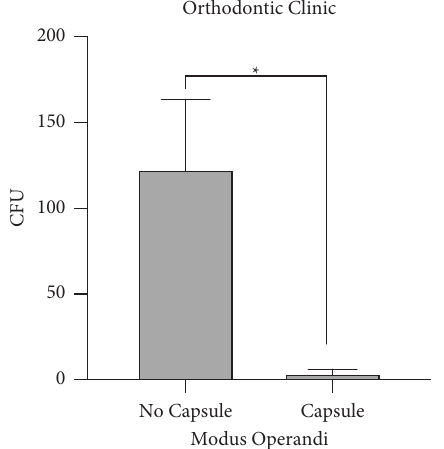
Figure 4: Comparison of aerosol production among two dental clinics with and without the